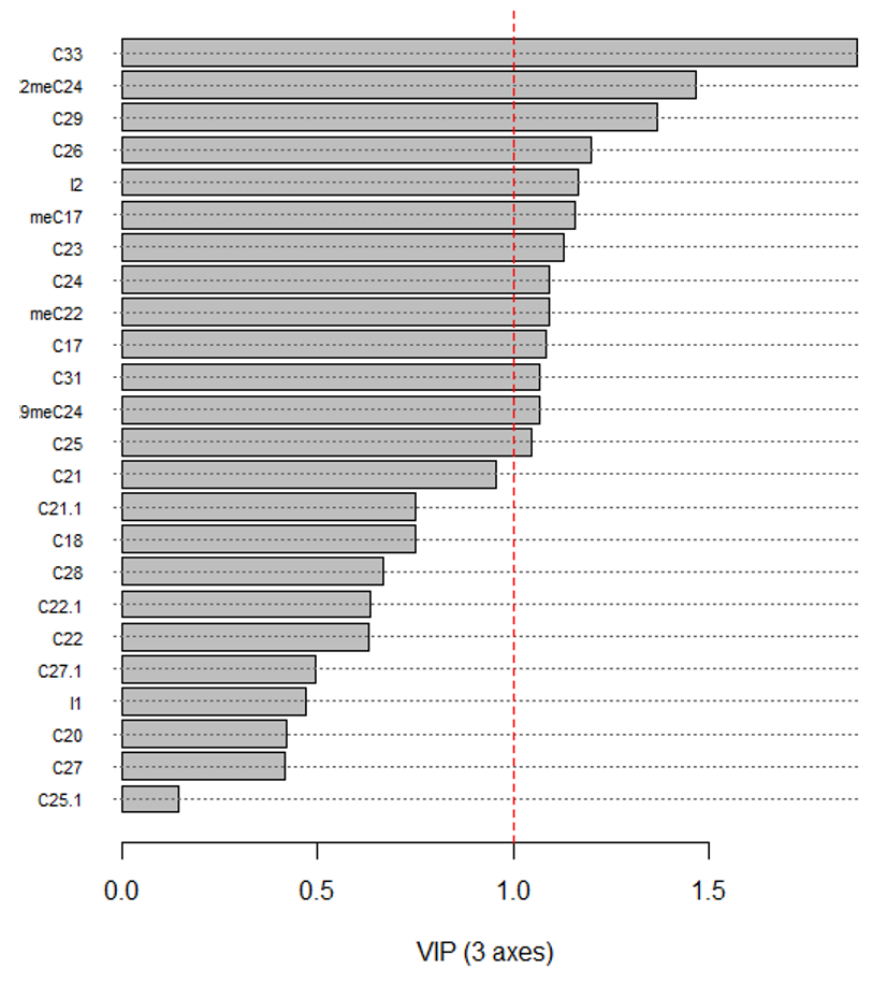
Figure 5: VIP classification showing the influence of CHC in discriminating the four population samples. VIP values larger than 1 (dashed red line) are most influential. See Table 1 for CHC